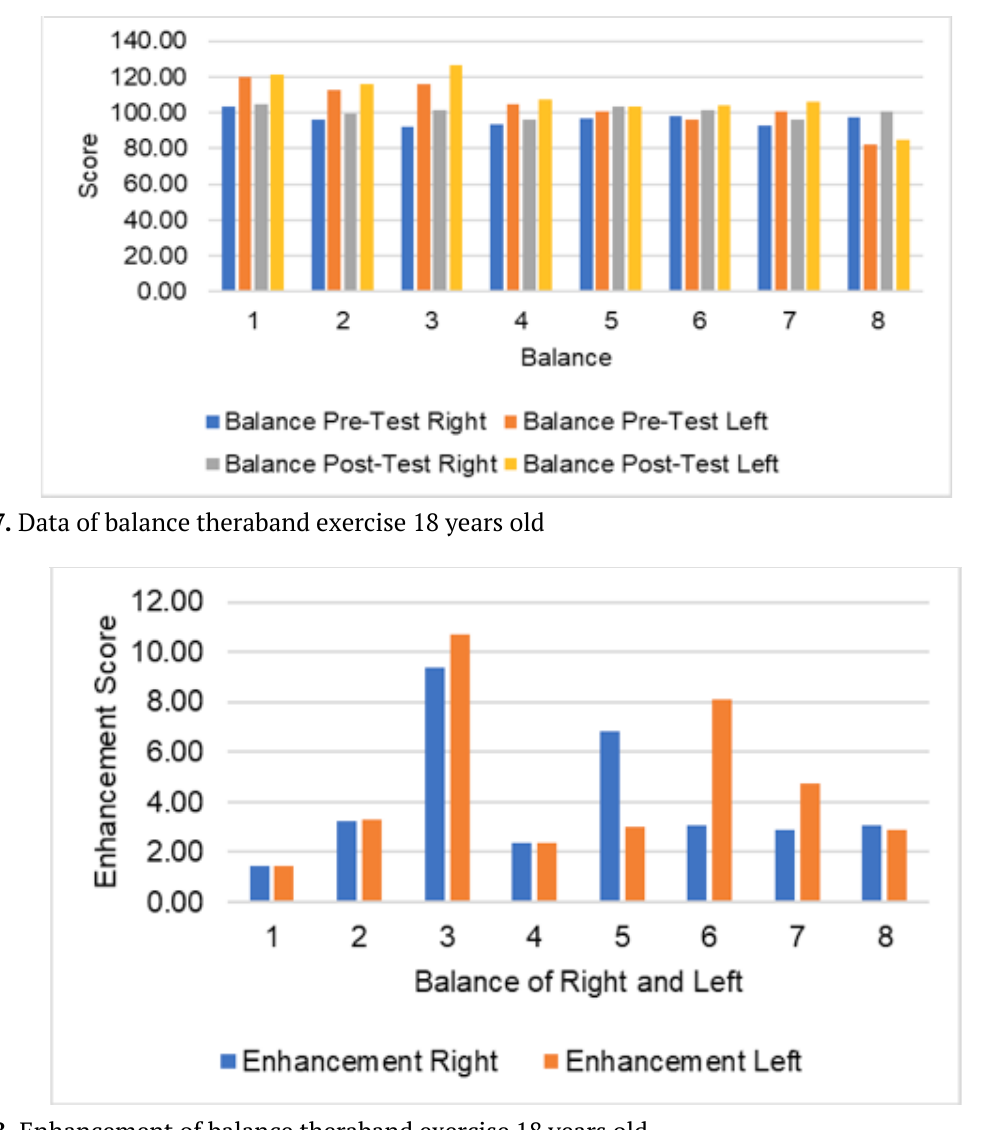
Figure 8. Enhancement of balance theraband exercise 18 years